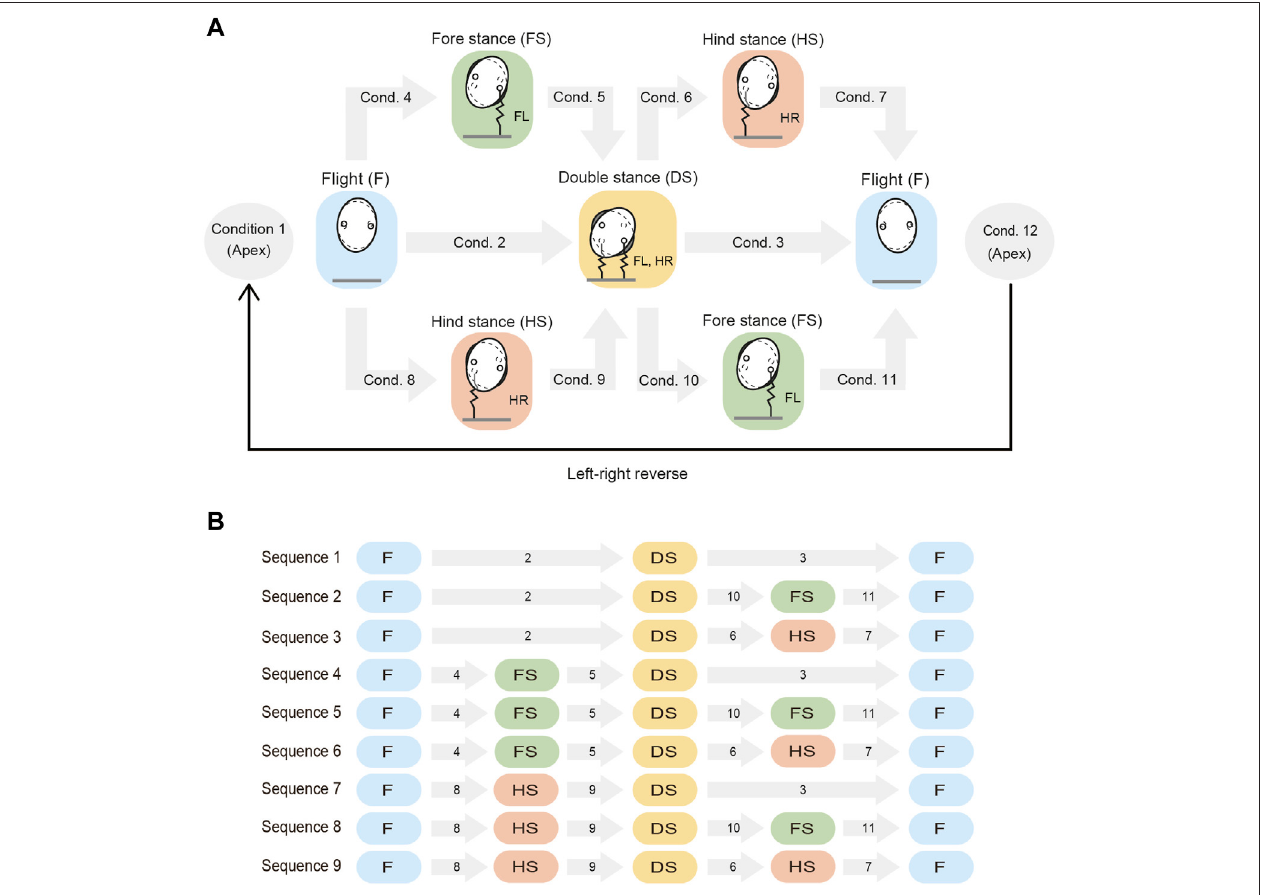
FIGURE 2 | Phase transitions from an apex to the next apex. (A) Possible phases and the associated phase transitions. The phase transitions occur when conditions1 – 12aresatis fi ed. Theleft and rightsidesofthemodel arethen reversedat the nextapex. (B) Ninesequences (Sequences1 – 9) explainthephase transitions from an apex to the next apex. Each gray arrow with a number indicates the condition of the phase transition. Conditions 1 and 12 are not shown because they are common to all sequences.